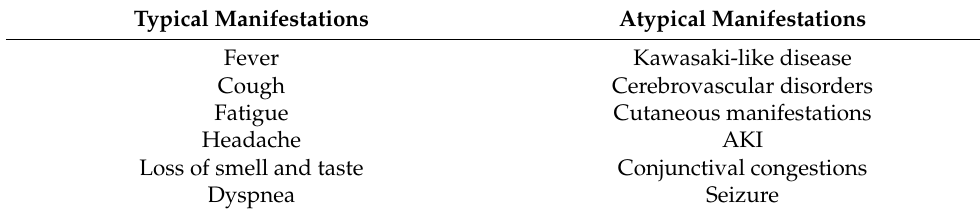
Table 1. Comparison of typical and atypical COVID-19 infection